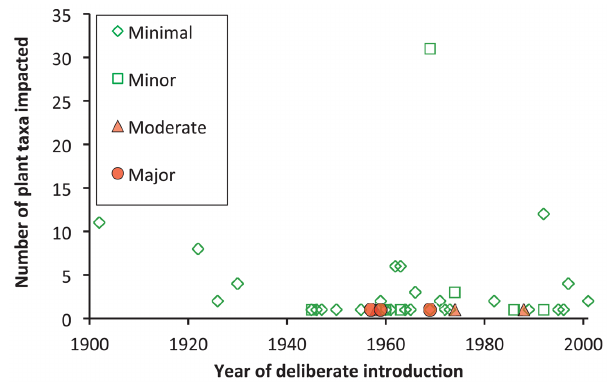
Figure 5. Year of deliberate introduction of arthropods used as weed biological control agents, sorted by magnitude of non- target impact on plant taxa.